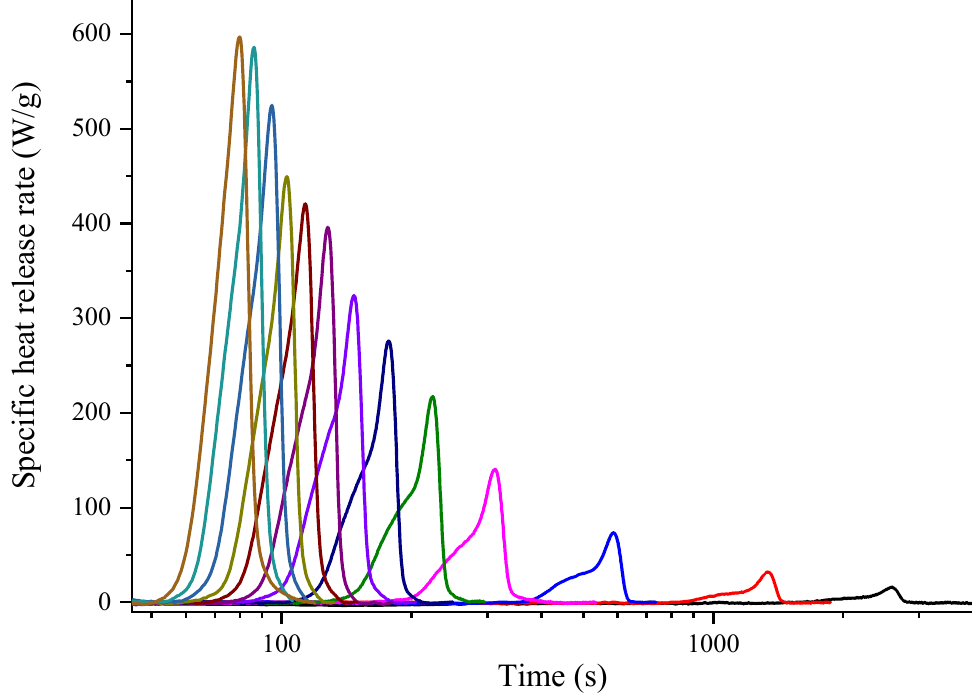
Figure 2. Specific heat release rate curve of BB sample with 13 heating rates ranging from 0.1 to 5.5 K s − 1 by MCC Method A. (Different color means different heating rates. From right to left is 0.1, 0.2, 0.5, 1.0, 1.5, 2.0, 2.5, 3.0, 3.5, 4.0, 4.5, 5.0, and 5.5 K s − 1